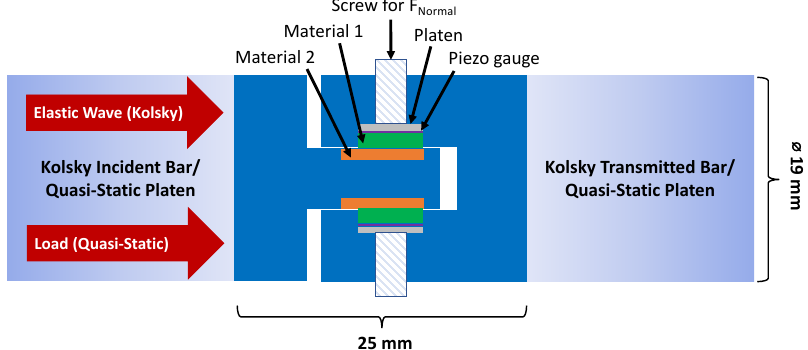
Fig. 1. Illustration of experimental friction fixture design to be incorporated into a compression